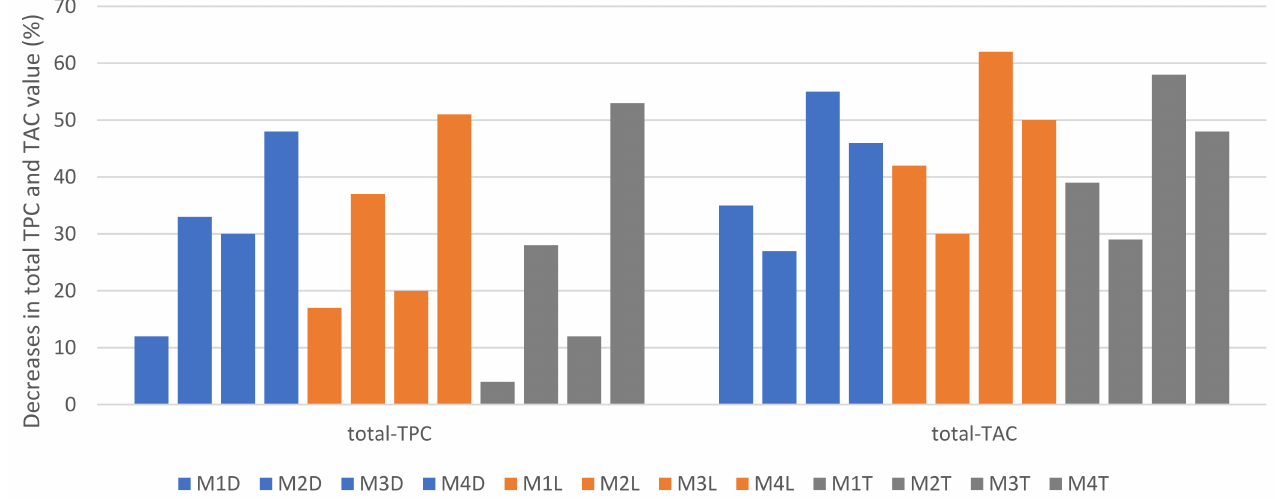
Figure 3. Percentage decreases in the concentrations of TPC and TAC values of the M1–M4 nutraceuti- cal mixtures under the defined storage conditions: D (storage without sunlight, blue color), L (storage in the presence of sunlight, orange color), T (storage in thermostatic device, grey